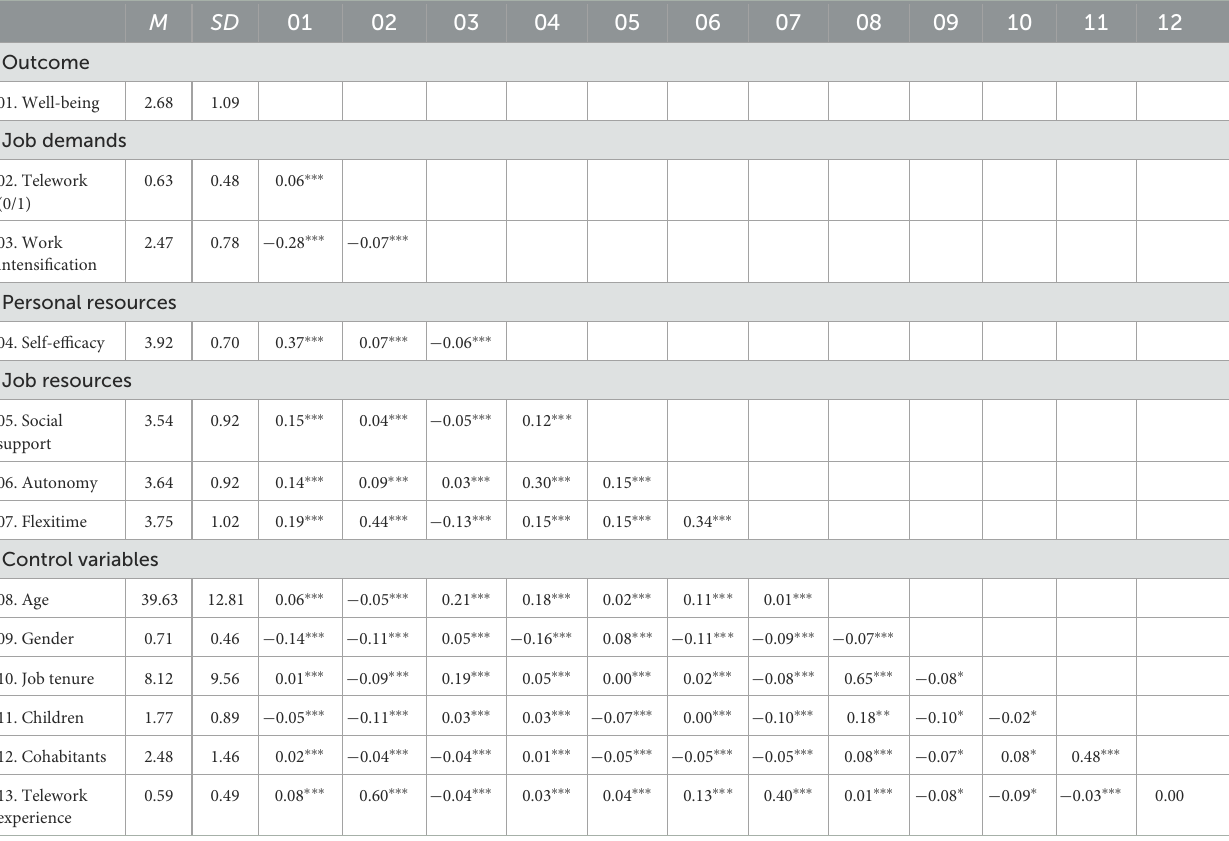
TABLE 2 Descriptive statistics and correlations among study variables at